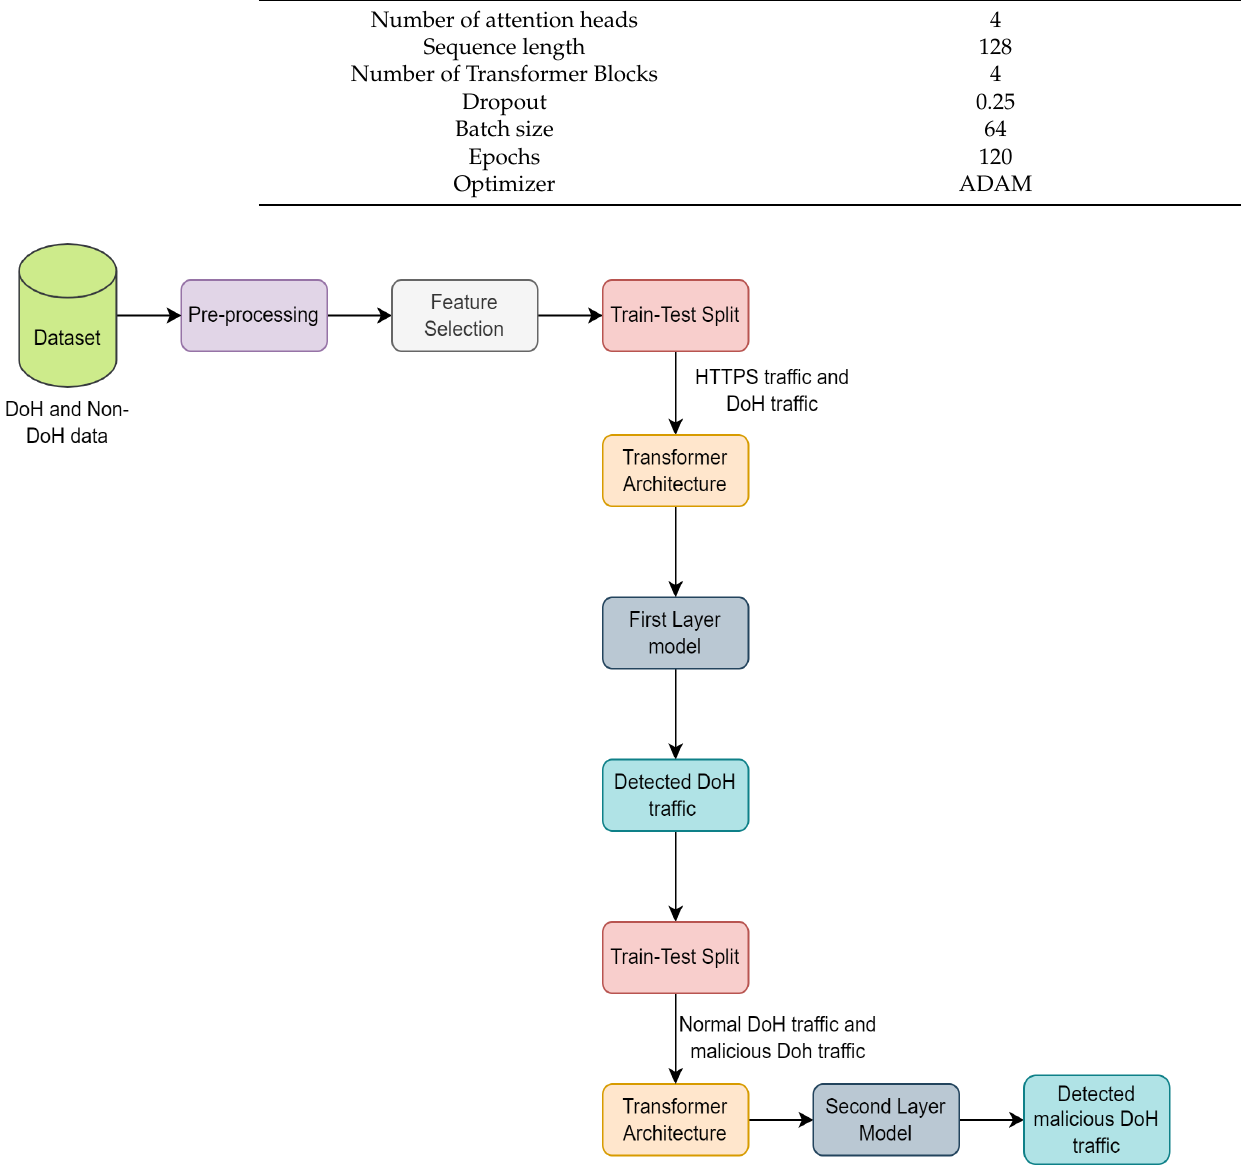
Figure 7. Training process phases for DoH tunneling attack